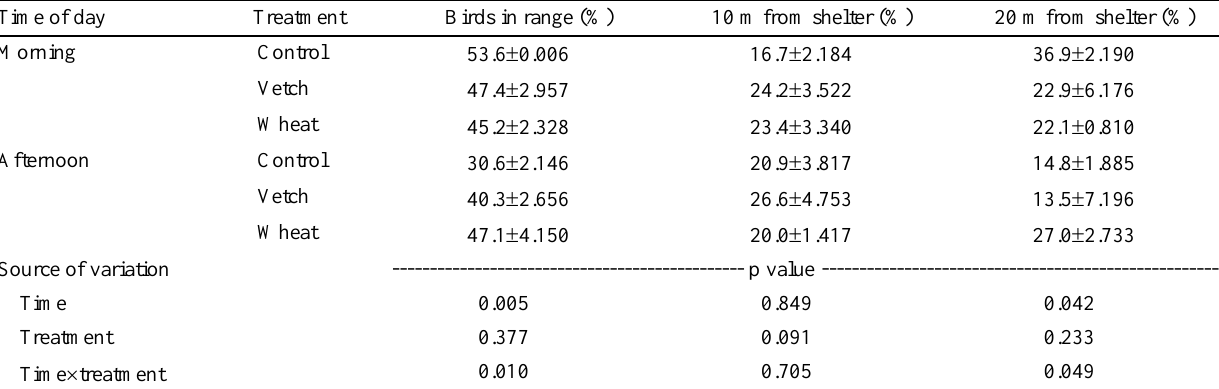
Table 3. The % of birds in the range 10 m and 20 m from shelter for birds provided no pasture (control), vetch pasture and wheat pasture